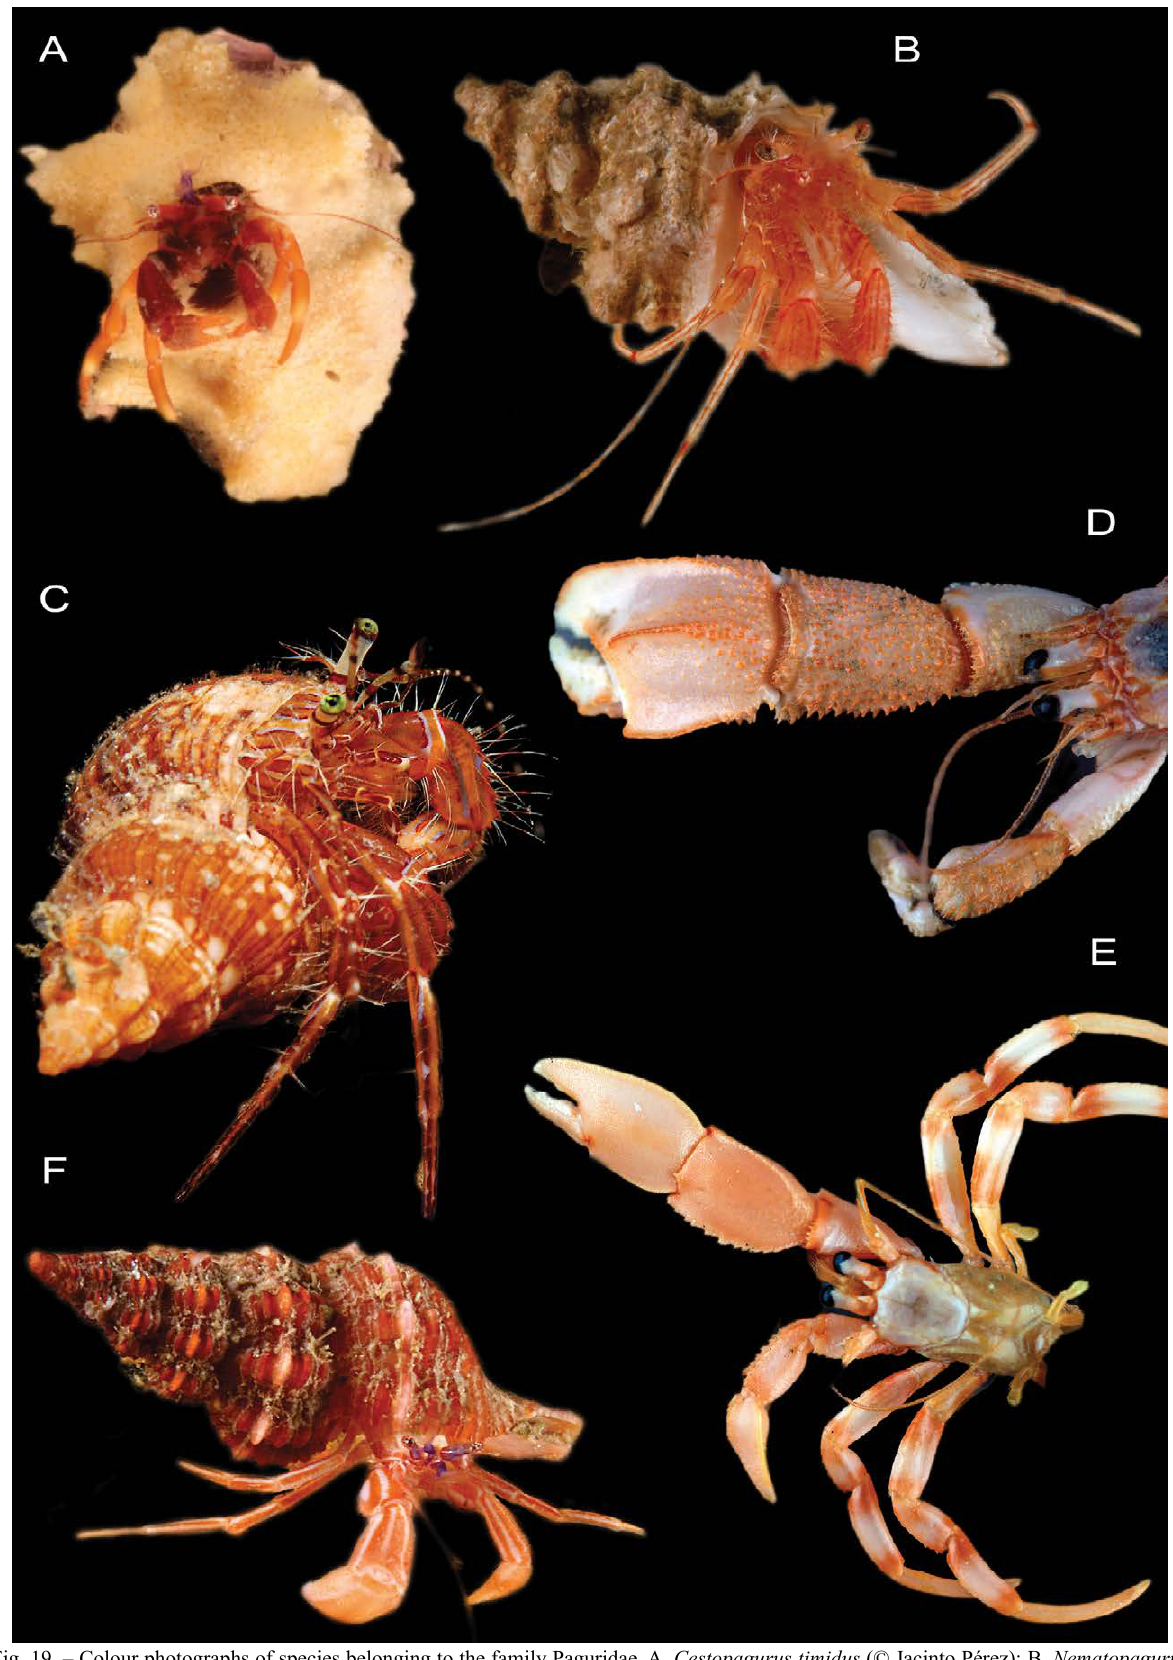
Fig. 19. – Colour photographs of species belonging to the family Paguridae. A, Cestopagurus timidus (© Jacinto Pérez); B, Nematopagurus longicornis (© Jacinto Pérez); C, Pagurus anachoretus (IEOCD-BR/285); D, Pagurus alatus (IEOCD-BR/3170); E, Pagurus carneus (IEOCD-POR13/286); F, Pagurus chevreuxi